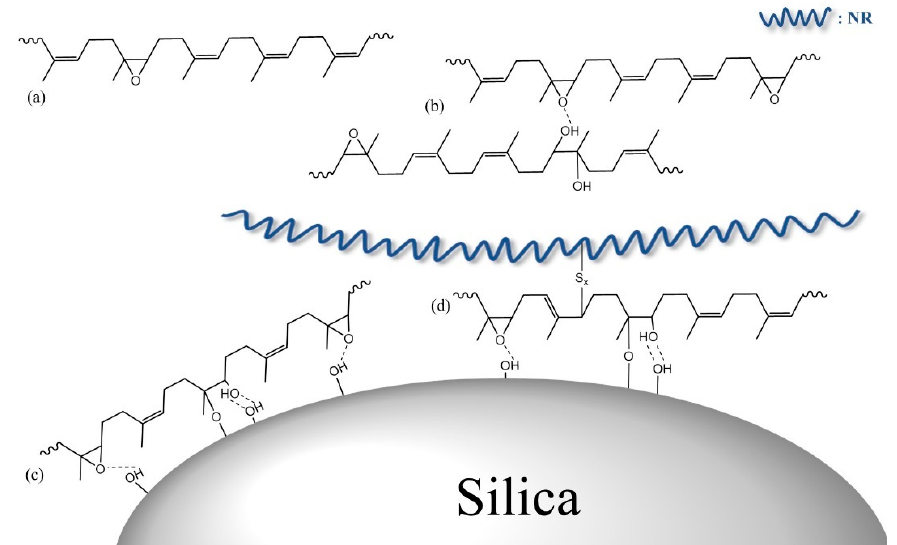
Figure 4. Proposed interactions of silica-filled NR vulcanizates with E-LqIRs: ( a ) E-LqIRs without interaction with silica and rubber, ( b ) hydrogen bonding of E-LqIRs via ring-opened epoxide groups, ( c ) E-LqIR as a silica covering agent, and ( d ) E-LqIR as a coupling agent owing to sulfur crosslinking.